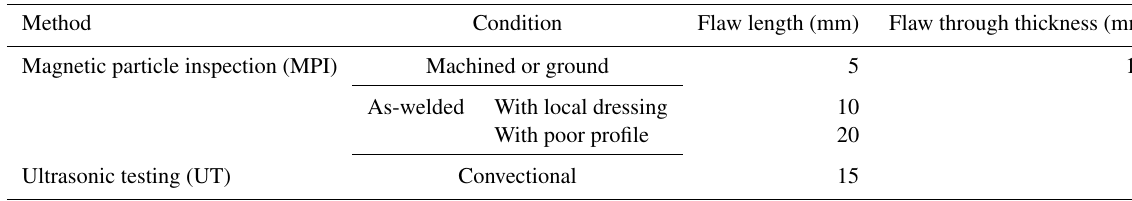
Table 1. NDT reliability (BS7910, 2015).